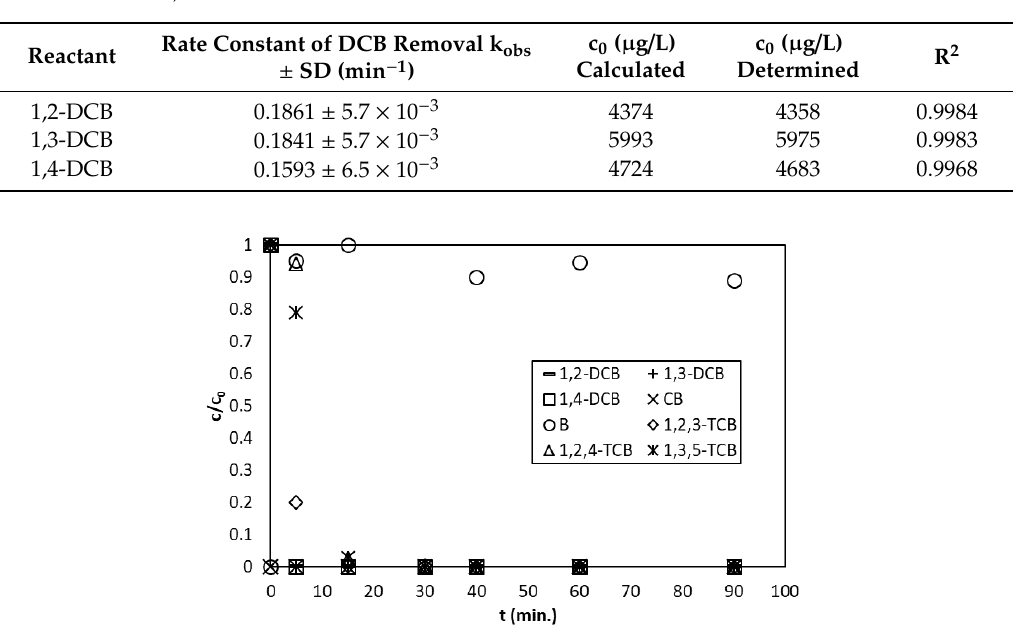
Figure 5. HDC rate of trichlorobenzene (TCB) mixture with the Raney Al-Ni alloy. The experimental procedure is described in Section 4.2.4.